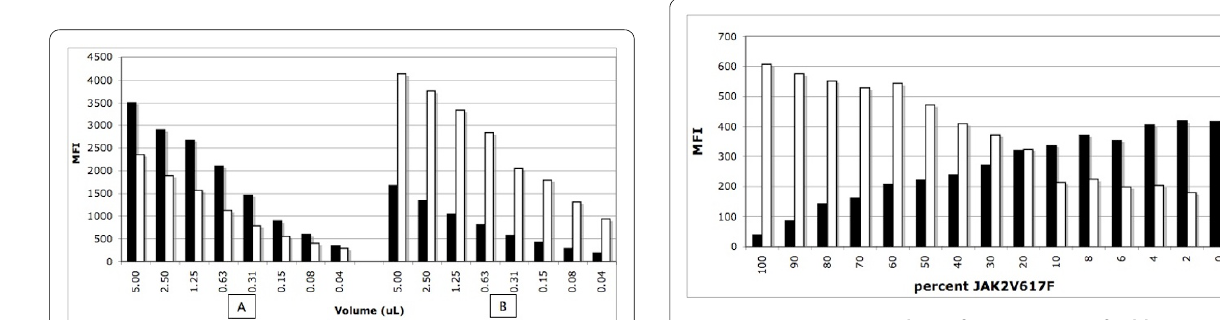
Figure 4 Quantitative analysis of various ratios of wild type vs mutant alleles . Various ratios of wild type and mutated alleles ranging from 0% up to 100% mutated allele were analyzed using direct hybrid- ization. Black bars correspond to the wild type probe (V617Fwt) and white bars correspond to mutated probe (V617Fmut). MFI: median flu- orescent